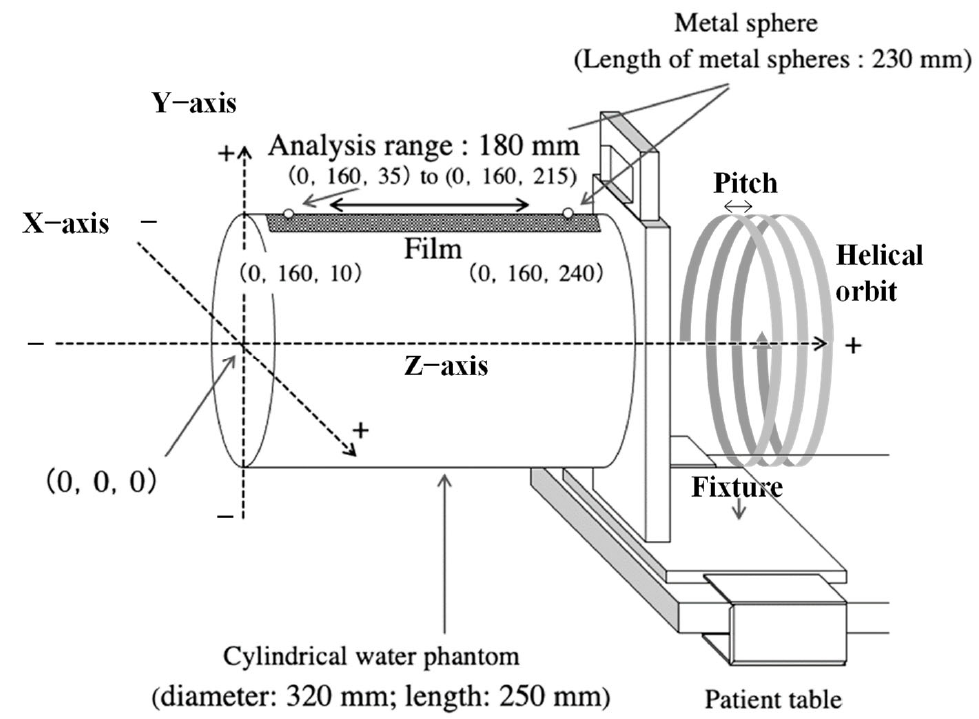
Figure 2. Overview of CWP on the multi-slice CT scanner table, with helical orbit and pitch. Scanning experiments were performed as follows.